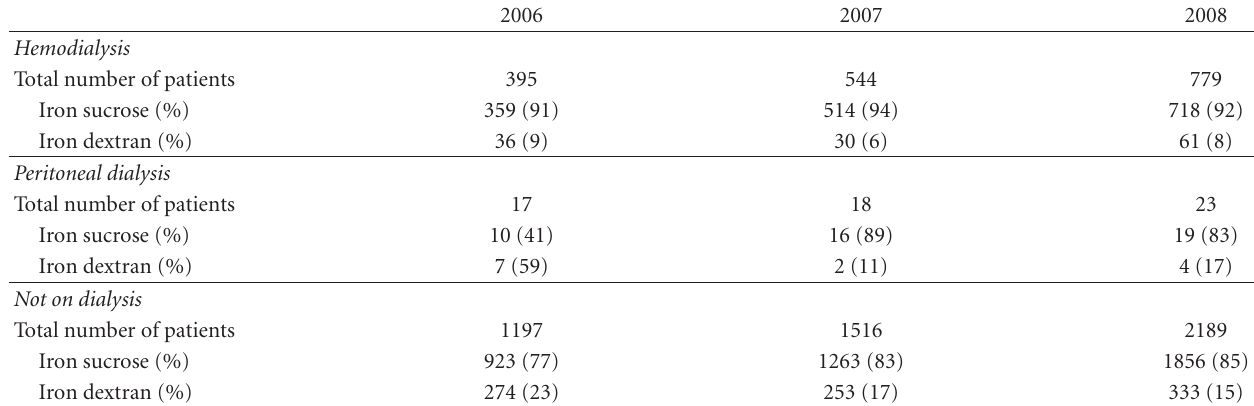
Table 6: Annual percentages of chronic kidney disease patients treated with IV iron.